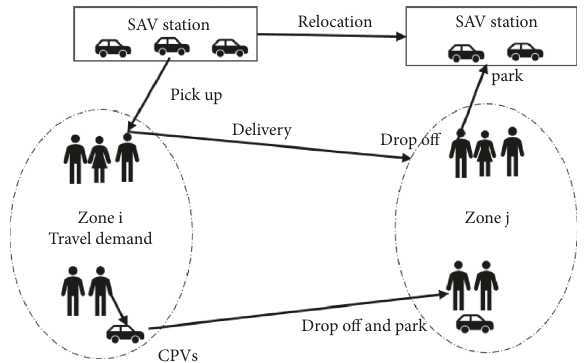
Figure 2: Representation of discrete mode choice.